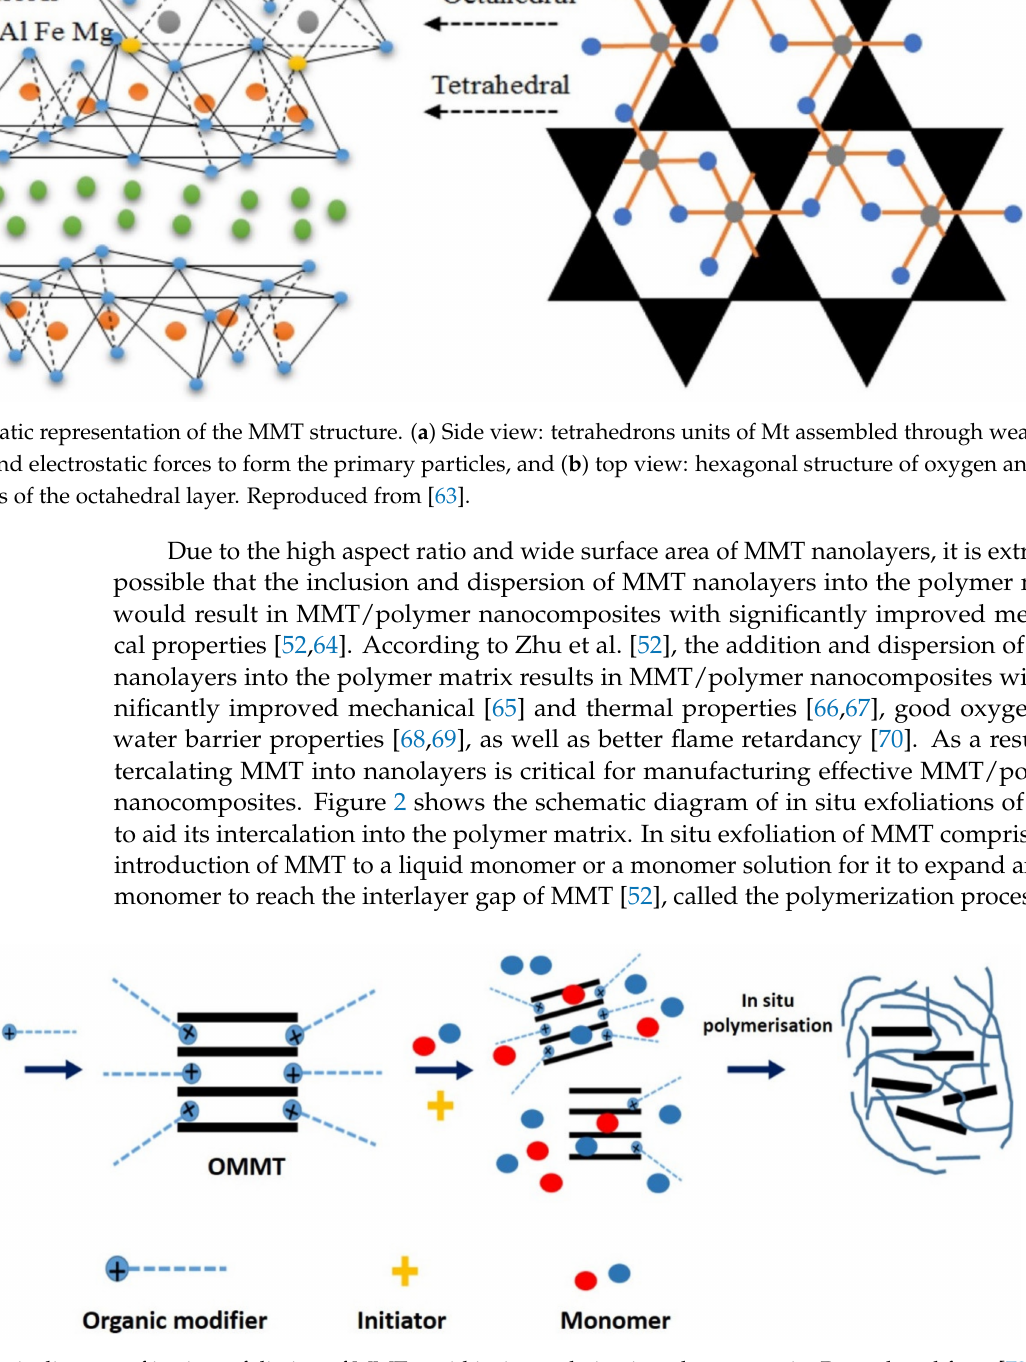
Figure 2. Schematic diagram of in situ exfoliation of MMT to aid its intercalation in polymer matrix. Reproduced from